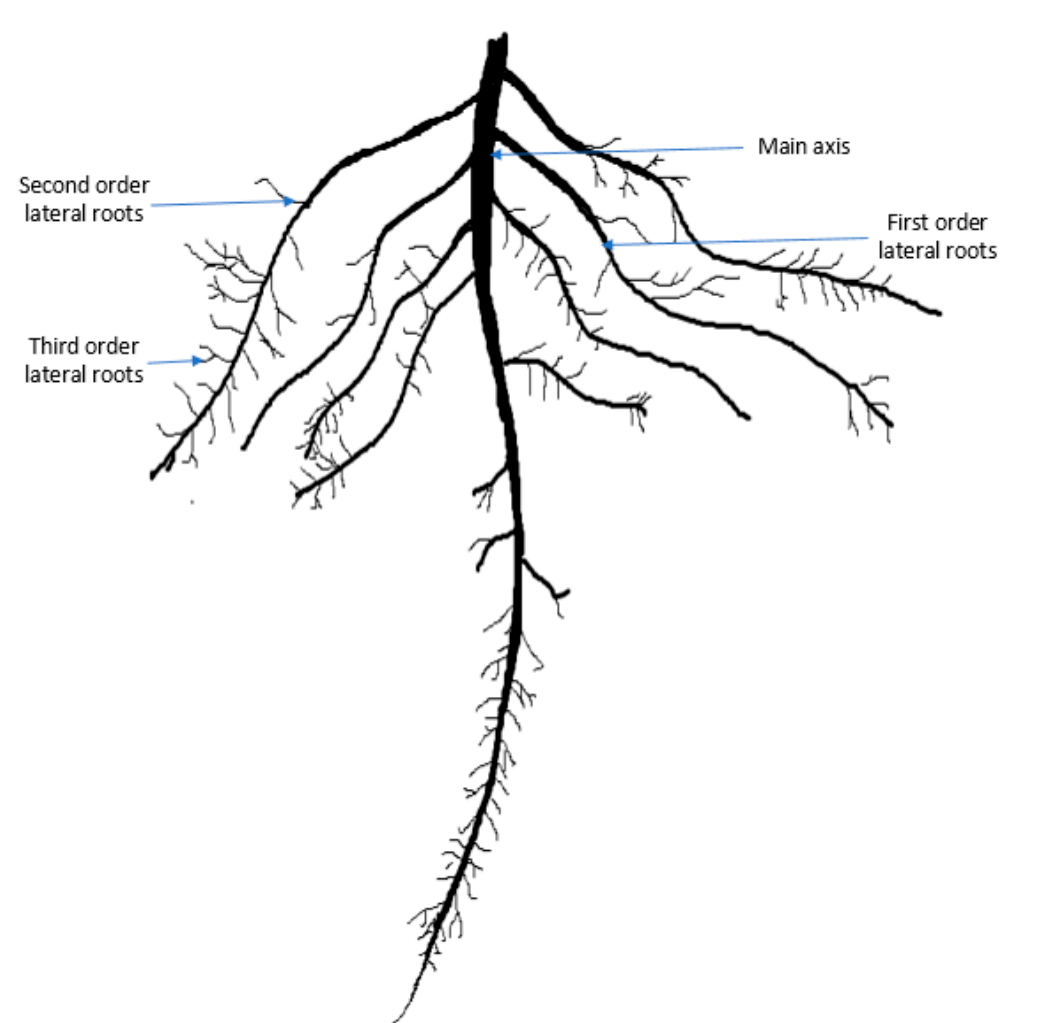
Figure 1. A typical root system architecture of Brassica napus . Root hairs appear on the main axis and all types of lateral roots.